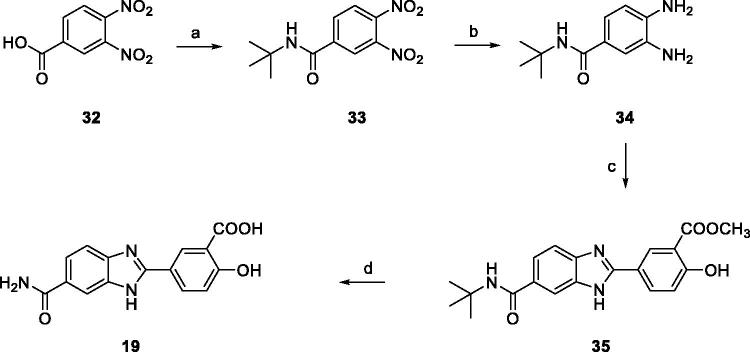
(a) SOCl2, reflux, 2 h, then tert-butylamine,
NEt3, THF, 0 °C to r.t., 18 h (84%); (b) ammonium formate, Pd/C 10%,
MeOH, reflux, 2 h (94%); (c) 25e, NaHSO3, dry DMF, 80 °C, 18 h
(72%); (d) DCM/TFA (1:1), r.t. 24 h, then LiOH, THF/H2O (1:1) r.t.,4 h
(91%).